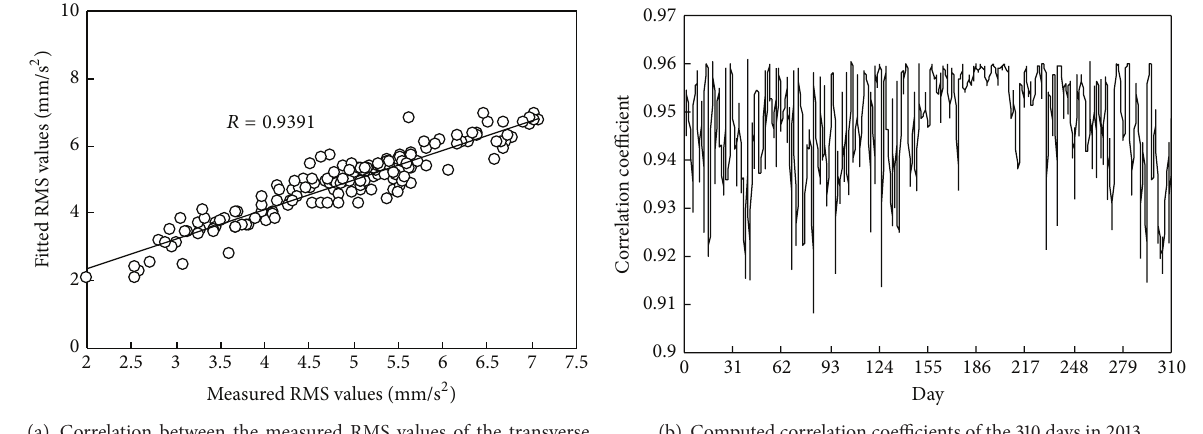
(a) Correlation between the measured RMS values of the transverse accelerations in the middle of the second span and the corresponding fitted values Figure 5: Fitting effect of cross-correlation between RMS values of transverse accelerations by using quadratic